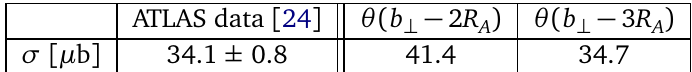
Table 5: Comparison of predictions for exclusive dimuon production in PbPb colli- sions, as in Table 1, but considering extreme variations in the modelling of survival effects, as described in the